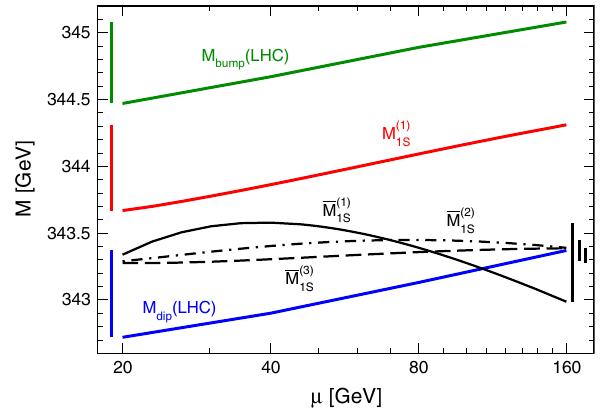
Fig. 3 Scale dependence of the dip and bump positions in the diphoton mass spectrum at the LHC evaluated with the NLO Green function, and the energy level of the 1 S toponium evaluated in the pole-mass scheme at NLO as well as those in the MS-mass scheme up to N 3 LO. m pole t = 173 GeV or m t = 163 GeV is